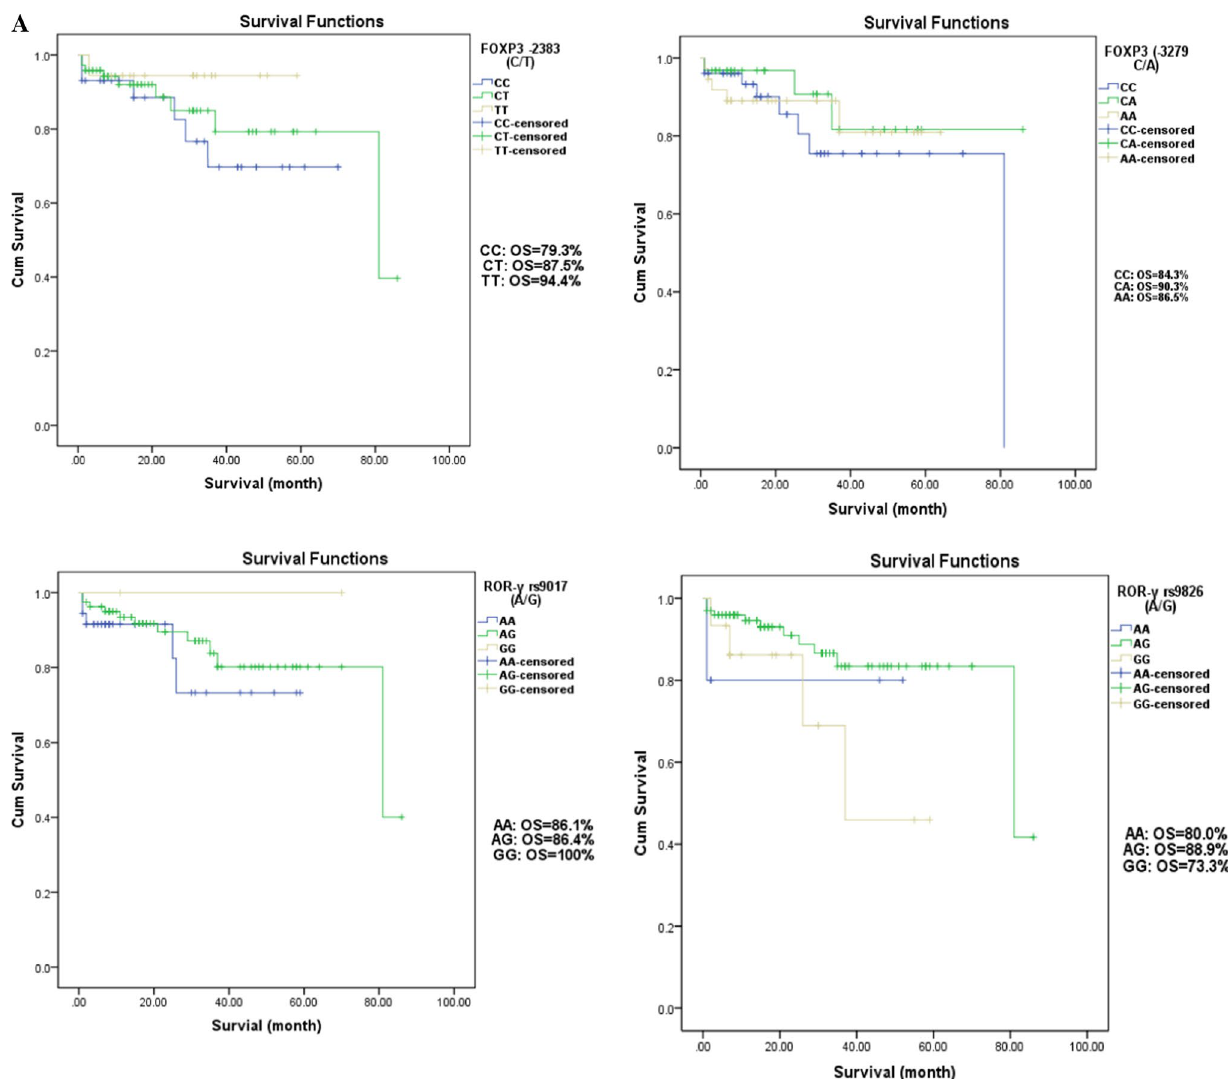
Fig. 2 a . Overall Survival according to FOXP3 (−2383 (rs3761549) C/T and −3279 (rs3761548) C/A) and ROR-γ (rs9017 A/G and - rs9826 A/G) SNPs in Pediatric ALL. b . Disease-Free Survival According to FOXP3 (−2383 (rs3761549) C/T and -3279 (rs3761548) C/A) and ROR-γ (rs9017 A/G and - rs9826 A/G) SNPs in Pediatric